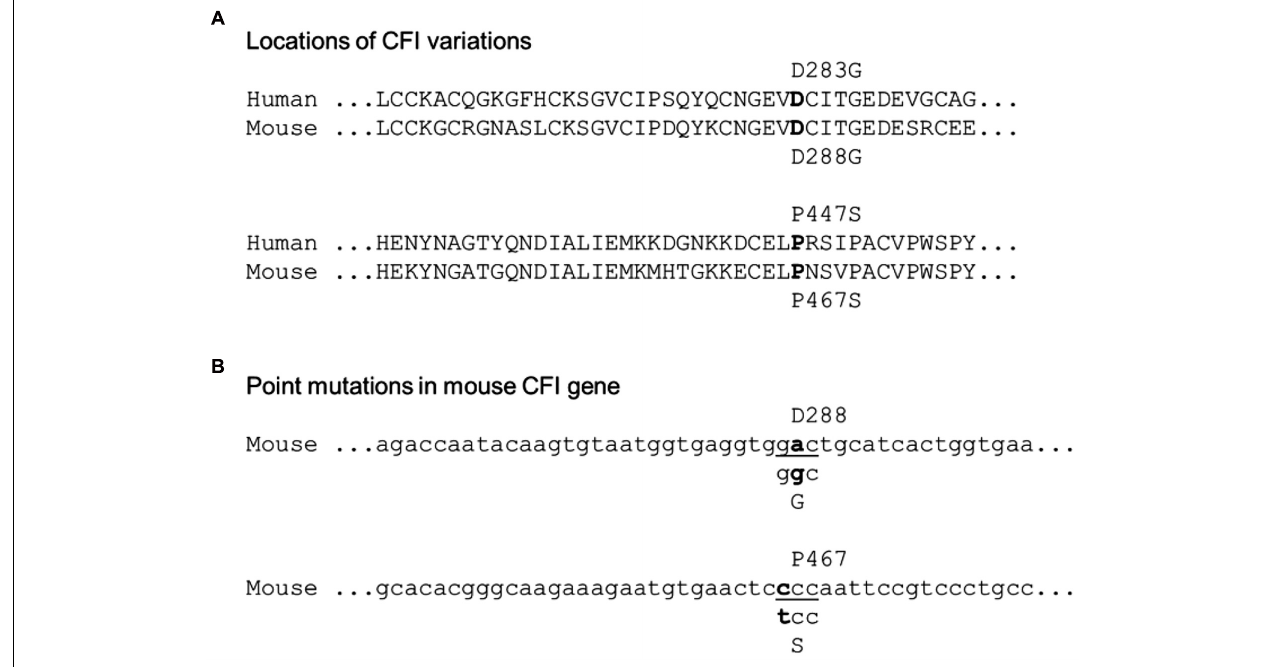
FIGURE 1 | Localization of the patient’s CFI variations in mouse counterpart. (A) Alignment of human and mouse CFI amino acid sequences near the variations. The human D283 vs. mouse D288 and human P477 vs. mouse P467 are indicated. (B) Design of point mutations in CFI gene to be made in mice: CFI D288 codon “gac” to be swapped to “ggc” for glycine (G), and P467 codon “ccc” to “tcc” for serine (S).